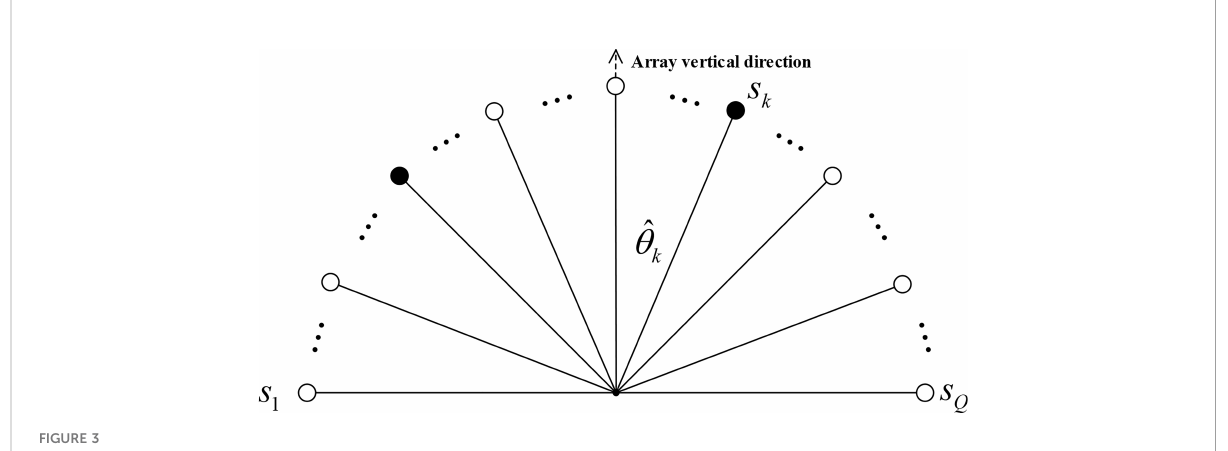
FIGURE 3 The schematic diagram of space